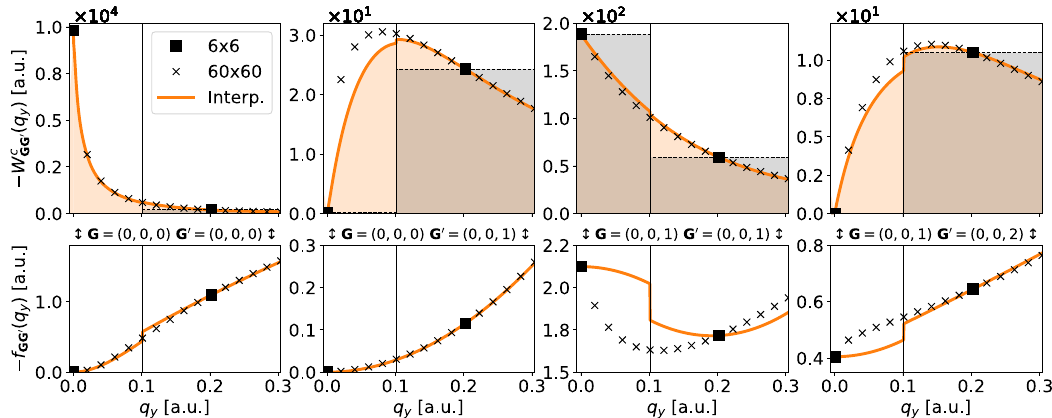
Fig. 3 Selected matrix elements of the correlation part of the screened potential (upper panels) and of the auxiliary function (lower panels) for the MoS 2 monolayer. Squares (crosses) are the numerical values obtained with a 6 × 6 × 1 (60 × 60 × 1) Monkorst – Pack grid. The interpolated functions between the points of the coarser mesh are plot with orange lines. The grey-shaded areas represent the values of the integral of W c when a simple trapezoidal rule is applied to the coarser grid (see the text for details about the missing contribution for G ¼ G 0 ¼ 0 and q ≈ 0). The orange-shaded area represent the values of the integral of W c obtained with the W-av method. Different domains of integration of the W-av method (which in 2D corresponds to the hexagons in the left panel of Fig. 2) are here separated with vertical black lines. We note the interpolation is discontinuous at the domain ʼ s border, as the interpolation procedure is applied at each domain separately. We remember that z here is the non-periodic direction. The auxiliary functions are multiplied by a factor 10 2 for